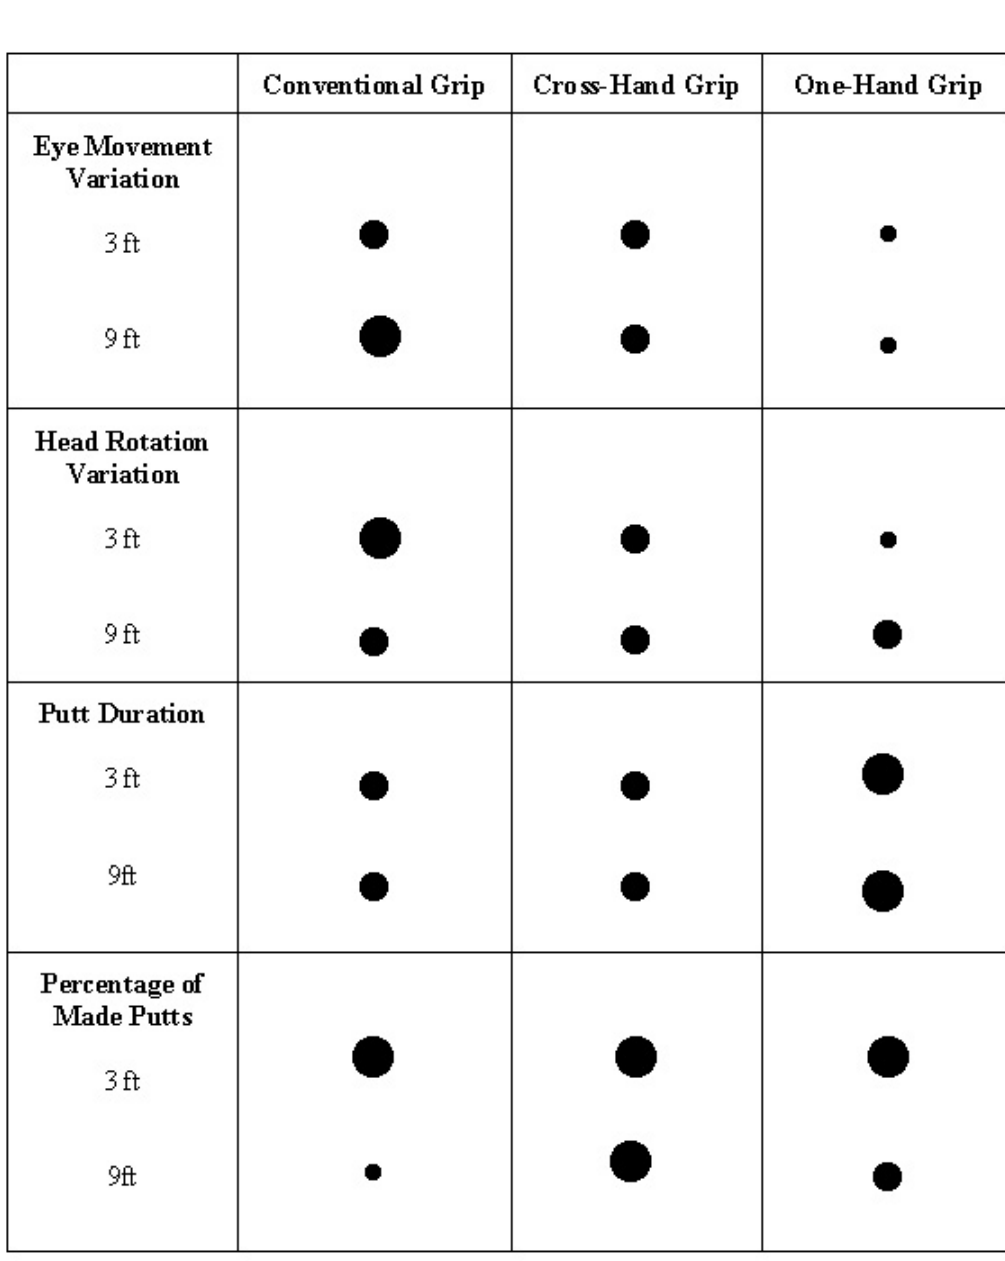
Table 2. Simpler-to-interpret illustration of same information as in Table